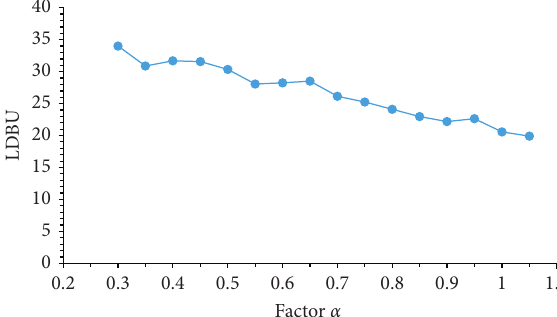
Figure 7: Evolution of LDUB in function of acceptance rate